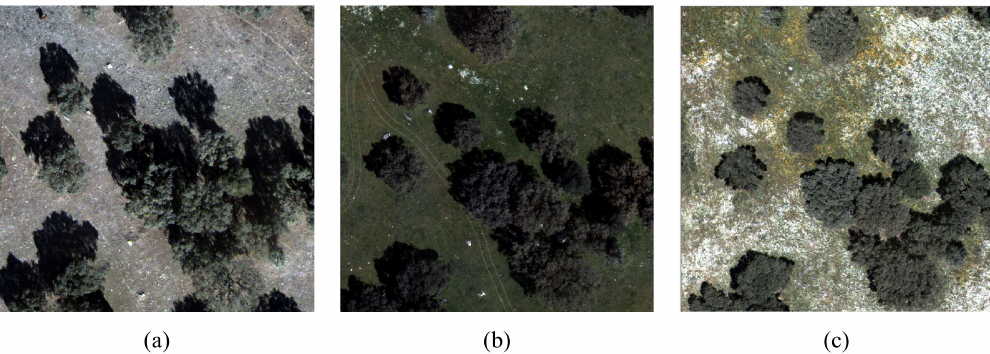
Figure 3. Extract of Unmanned Aerial Vehicle (UAV) imagery of farm 3 in di ff erent periods: 10th November 2017 ( a ), 4th April 2018 ( b ) and 15th May 2018 ( c